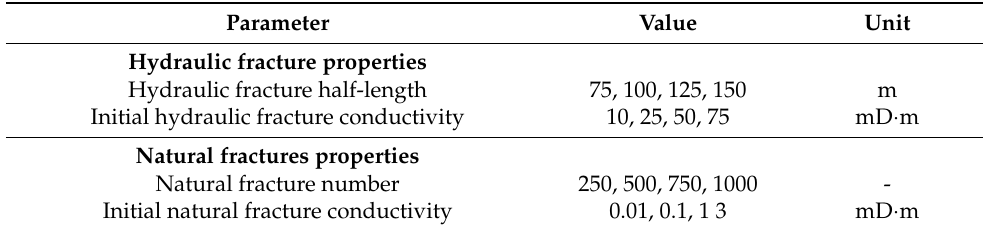
Table 1. Parameters values for sensitivity studies.